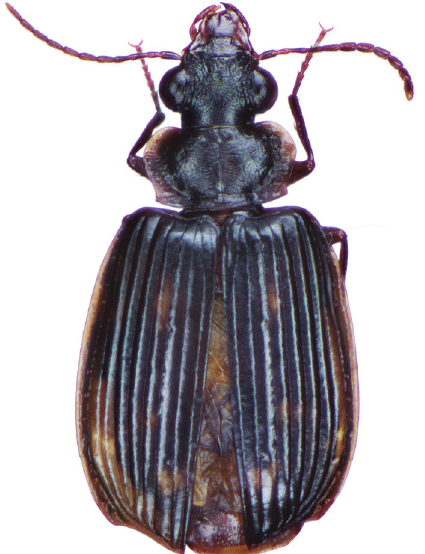
Figure 39. Dorsal habitus and color pattern of C. ( Coptoderina ) eluta Andrewes. (OBL 6.44